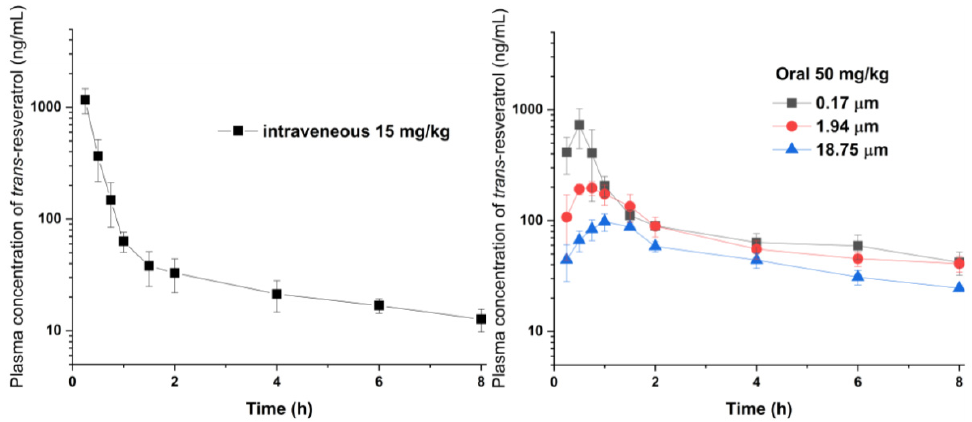
Figure 5. Effect of particle size on the plasma concentration of trans ‐ resveratrol after oral administration to Sprague–Dawley (SD) rats. Data are expressed as mean ± standard deviation ( n = 6).